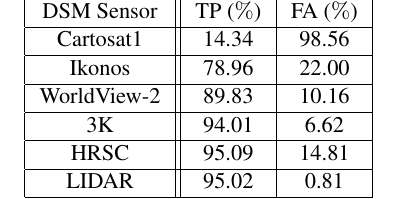
Table 1: Pixel Based Building Groundfloor Detection Perfor- mances for Six Different DSMs